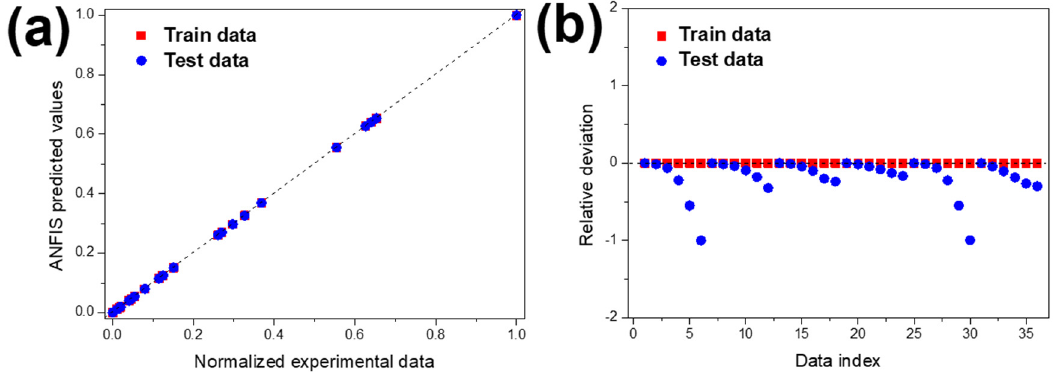
Figure 10. ( a ) Regression plot of the ANFIS model and ( b ) relative deviation for test and train